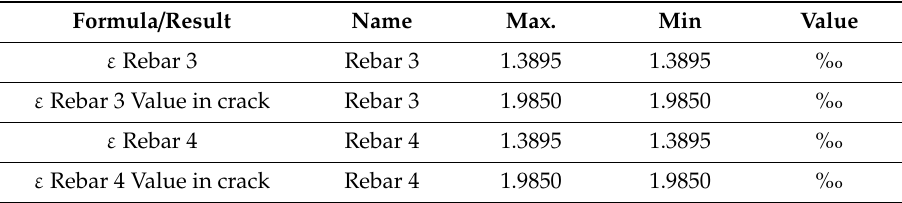
Table 4. Deformation of rebars 3 and 4 for a moment of 28.31 mkN by FAGUS. Formula / Result